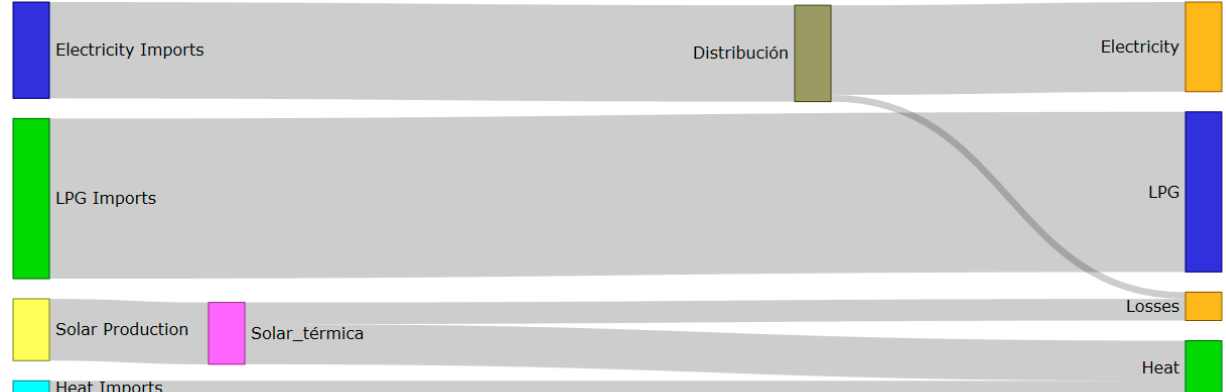
Figure 11. Scenario 1. Sankey diagram for 2030, residential sector (The figure shows the electricity losses given by the local distribution company. In addition, the losses of conversion of solar energy to heat are displayed. Losses due to the commercialization and distribution of LPG have not been included).